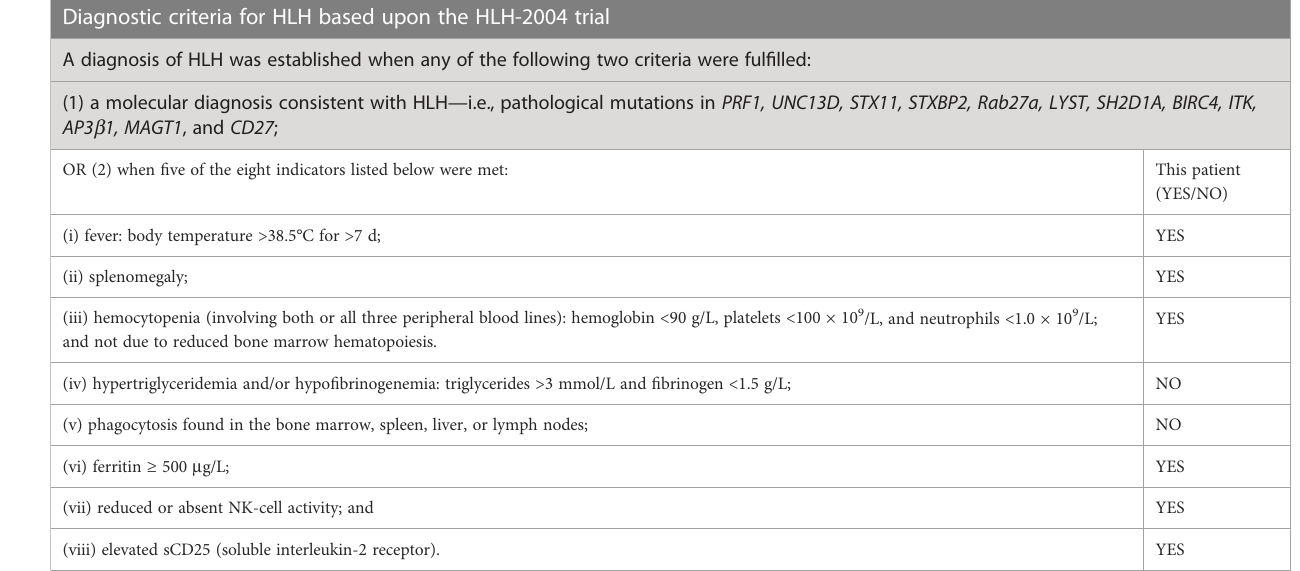
TABLE 2 Rationale for the diagnosis of